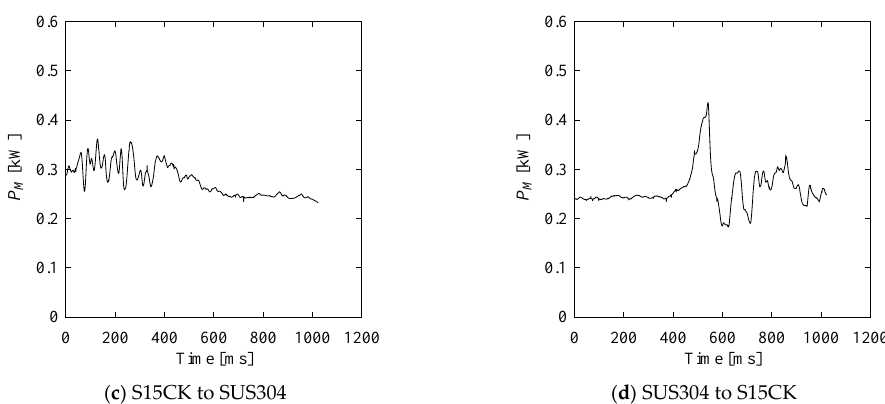
Figure 10. Machining power of the SU SC bimetallic specimen ( v c = 25 m/min, f = 0.2 mm/rev).